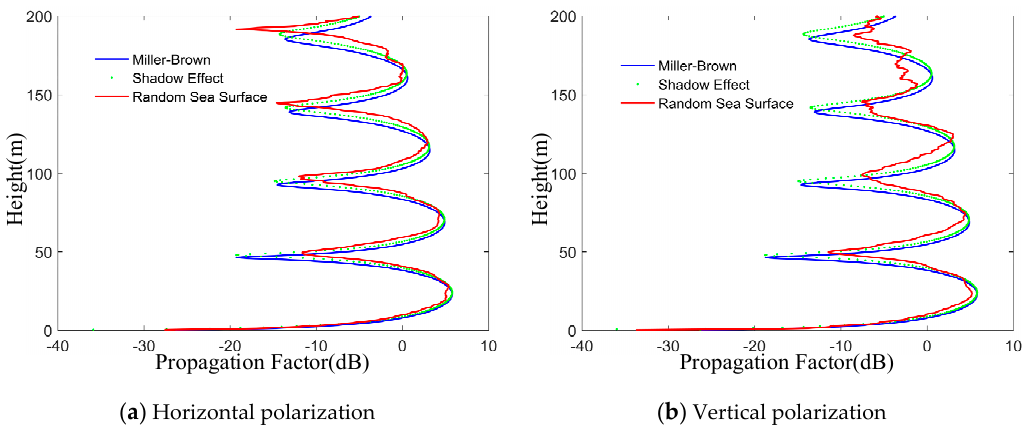
Figure 14. The effects of polarization on different models. The two examples ( a ) Horizontal polarization and ( b ) Vertical polarization, show propagation factors of random sea surface model, Miller-Brown model and shadow effect at different polarization modes. The wind speed is 7 m/s. The propagation distance is 13 km.